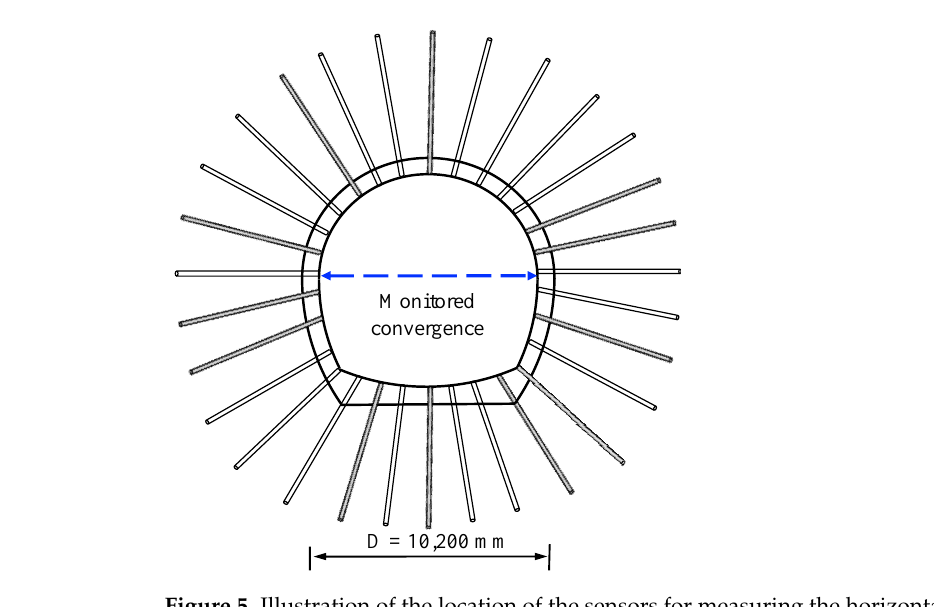
Figure 5. Illustration of the location of the sensors for measuring the horizontal convergence.